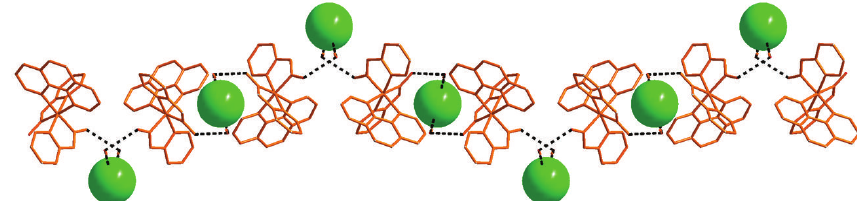
Figure 3: A part of the 1D structure of 1 · 2H 2 O due to H-bonding interactions (dashed lines) along the a axis. Chlorides (green) are emphasized using space filling models.